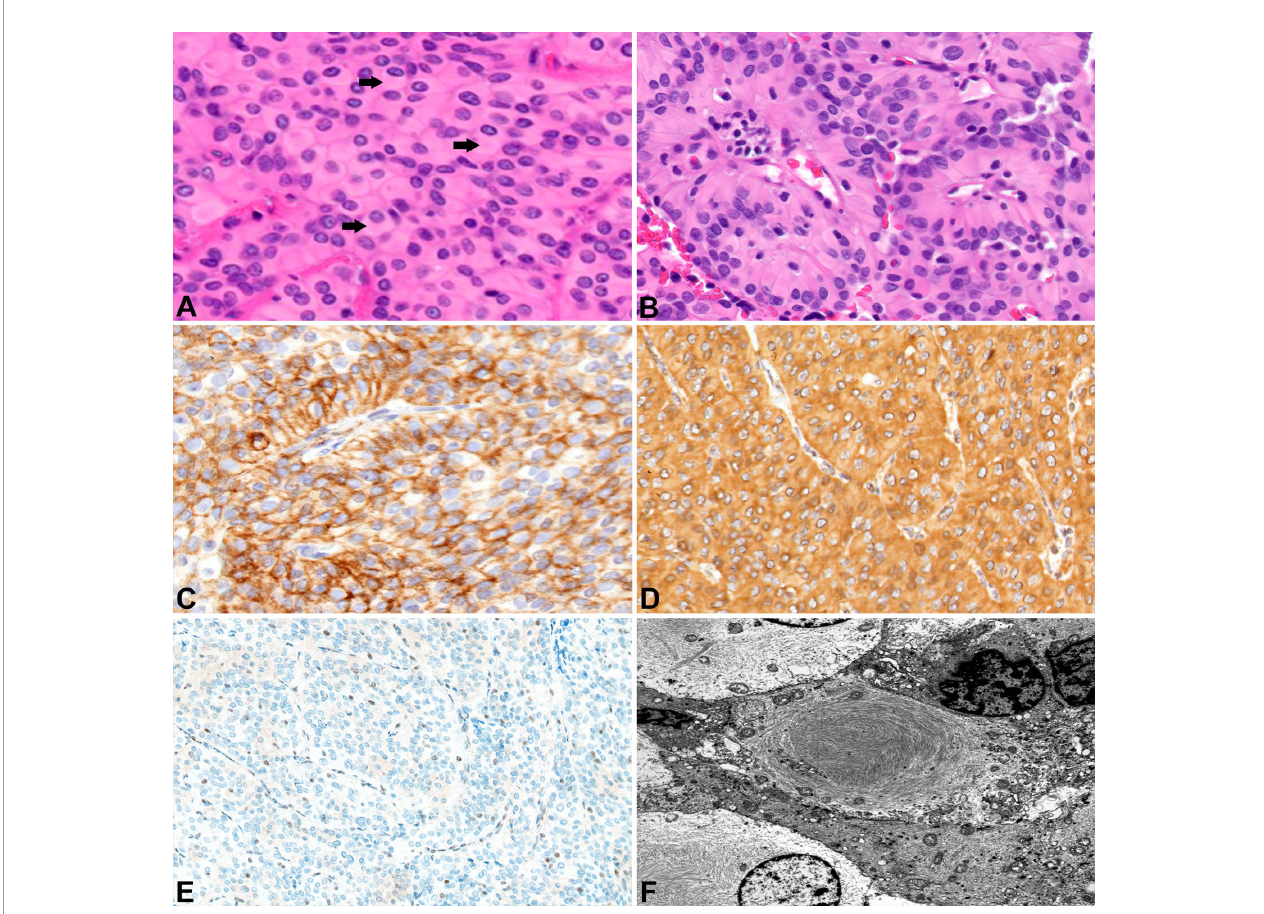
FIGURE 2 | Surgical pathology for Patient A H&E stained sections show numerous rhabdoid tumor cells with cytoplasmic hypereosinophilic inclusions (arrows) (400x) (A) . Papillary features are also readily apparent (200x) (B) . EMA highlights the tumor cells (200x) (C) . The tumors cells label for vimentin (200x) (D) . There is loss of BAP-1 immunoreactivity in the tumor cells with appropriate internal positive controls (endothelial cells) (100x) (E) . Ultrastructural studies revealed cytoplasmic whorls of intermediate fi laments (F)